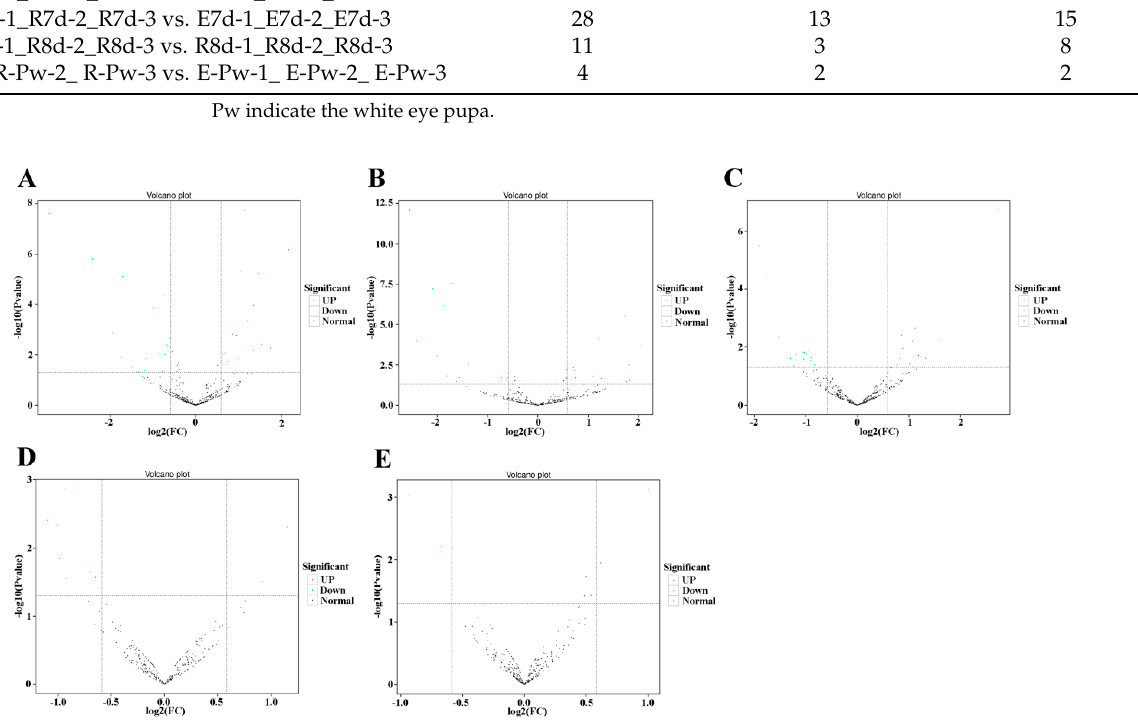
Figure 1. Volcano plot of DE miRNAs in ( A ) R5d vs. E5d; ( B ) R6d vs. E6d; ( C ) R7d vs. E7d; ( D ) R8d vs. E8d; and ( E ) R-Pw vs. E-Pw.